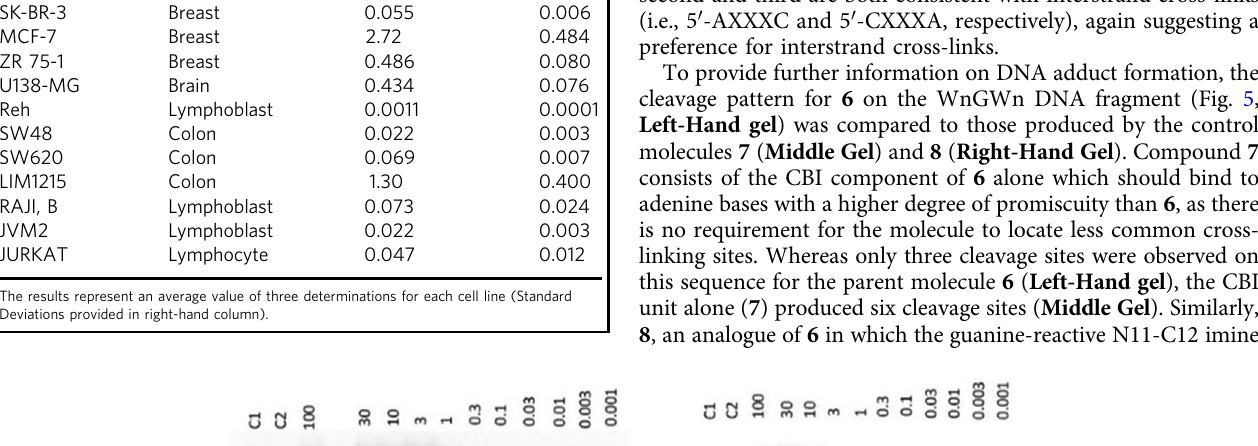
Table 1 IC 50 values for FGX8-46 (6) across a panel of 11 human cancer cell lines after 72 h incubation using an MTS assay (see Methods section).